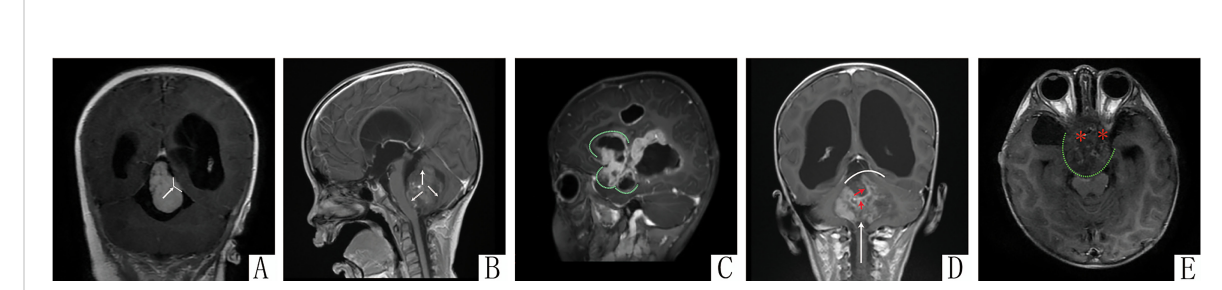
FIGURE 4 The imaging features related to the en bloc concept application. (A) The “ limited line ”– transverse T1 MRI con fi rming the boundary line (black arrow) between tumor (block pound sign) and the right thalamus (black asterisk). (B) The “ clear line ”– sagittal T1 post-contrast shows the thin hypointense gap between tumor and brainstem, velum medullare superius, and uvula of vermis (white arrow); (C) The “ fi nger-like ” attachment- Sagittal T2 post-contrasting MRI showing the “ Cauli fl ower-like ” outline of tumor. (D) The bottom vessel – sagittal T1 post-contrast MRI showing a feeding vessel (red arrow) originating from the “ bottom ” (white curve) of tumor that is relative to the direction of surgical approach (white arrow). (E) The “ perforating nerves or vessels ”– sagittal T1 post-contrast MRI showing the affected auditory and cranial nerve (red